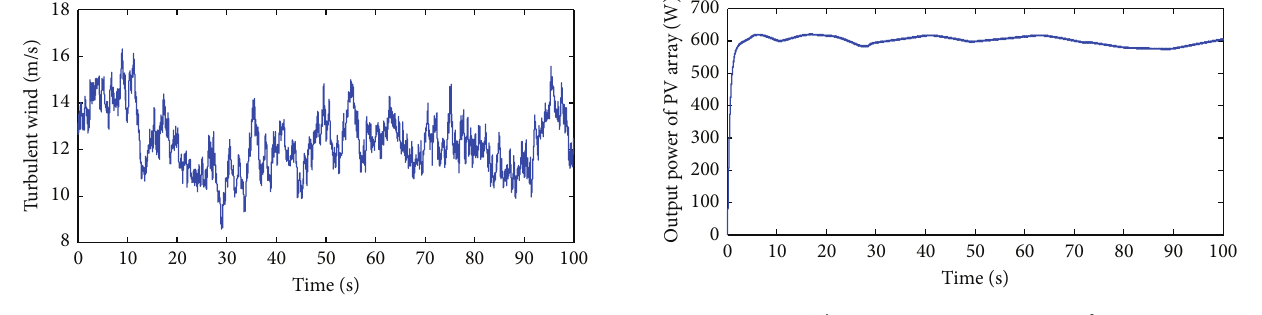
Figure 2: Turbulent wind of 13m/s from Bladed/FAST software.